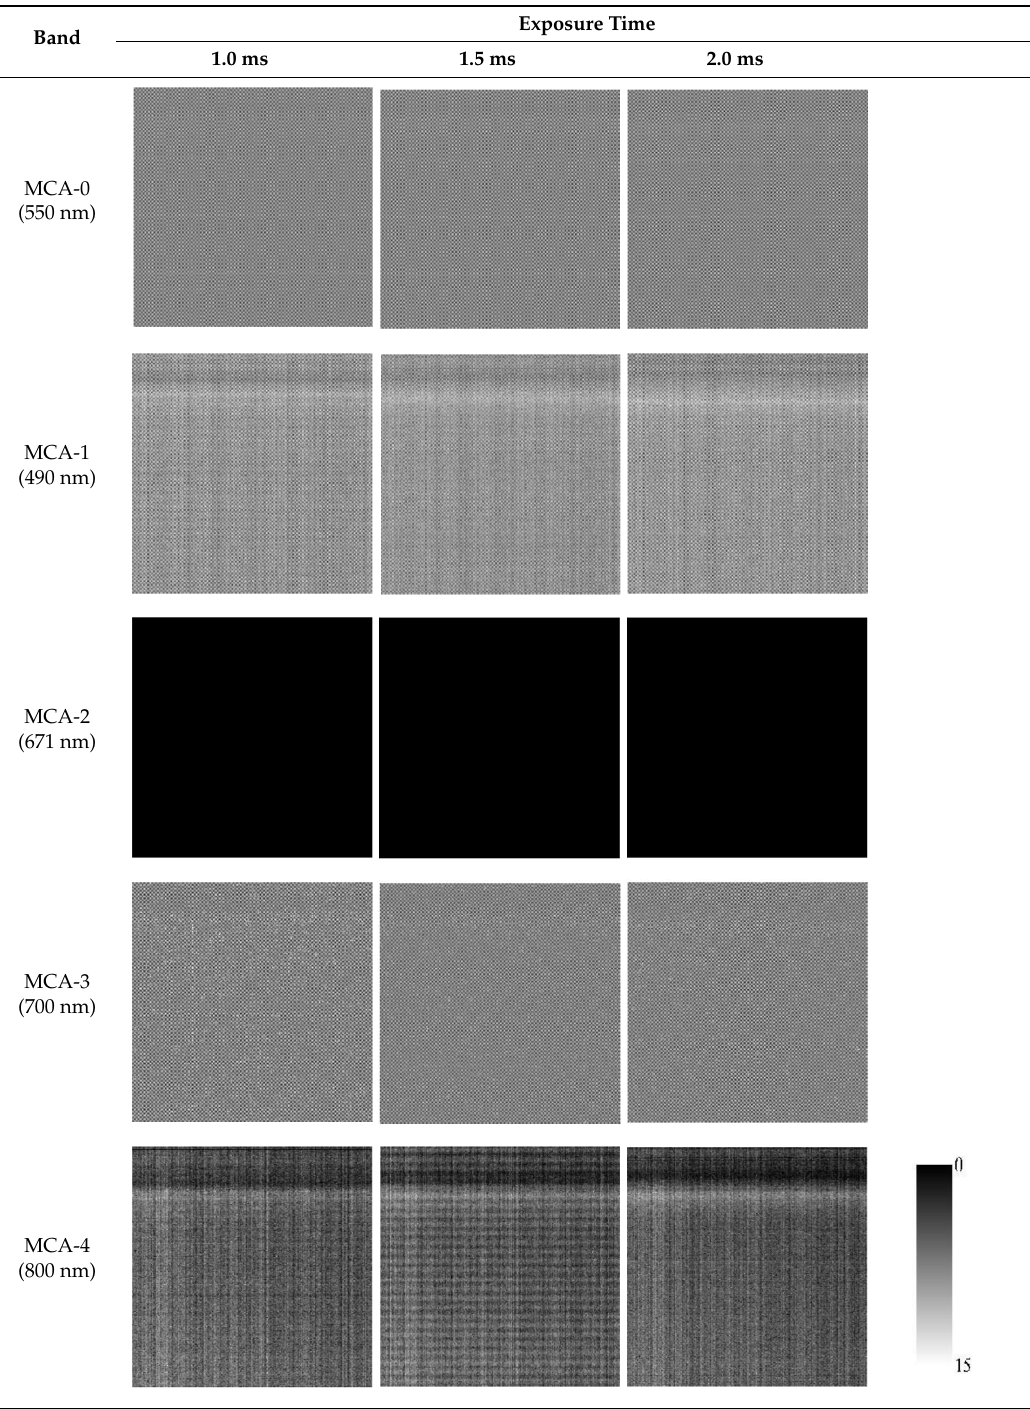
Table 6. The average noise images for the five channels of the Mini-MCA6 at different exposure